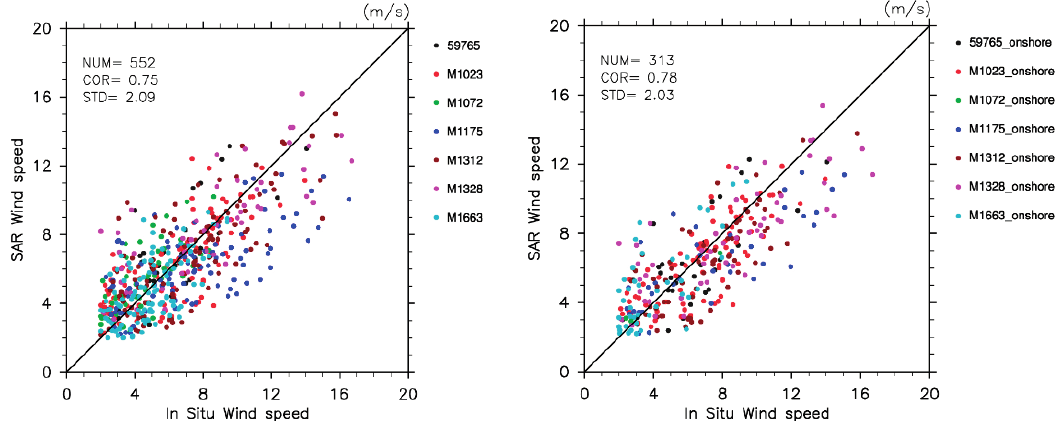
Figure 6. In situ wind speeds from seven meteorological stations vs. SAR wind speeds for all samples (left, N = 552) and onshore samples (right, N =